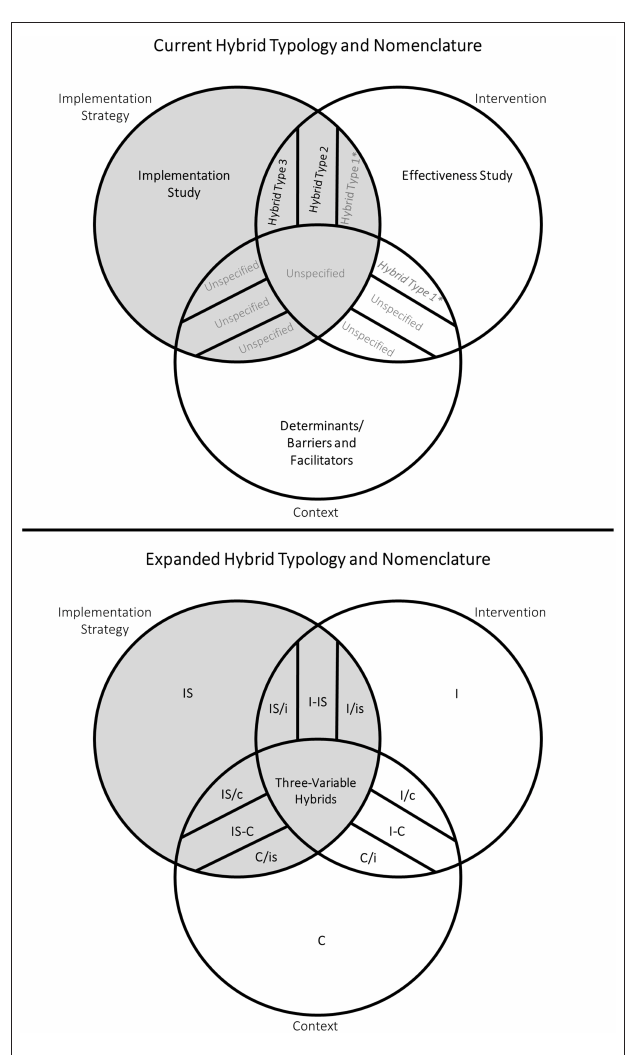
FIGURE 1 | Current and expanded hybrid typologies for implementation research. Gray shading represents study types where the assessment of implementation strategies is a primary or secondary aim. Gray text indicates study types that are currently under- or unspecified. Individual types of three-variable hybrids have been excluded for simplicity. *Curran et al. (1) specify that Hybrid Type 1 studies have a primary aim of testing intervention effectiveness and a secondary aim of gathering information on implementation (e.g., reporting implementation outcomes like feasibility and sustainability) or better understanding the context of implementation (e.g., identifying barriers and facilitators) (9). Therefore, we argue that some Type 1 studies mix the independent variables of intervention and implementation strategy ( I/is ), while others mix the independent variables of intervention and context ( I/c